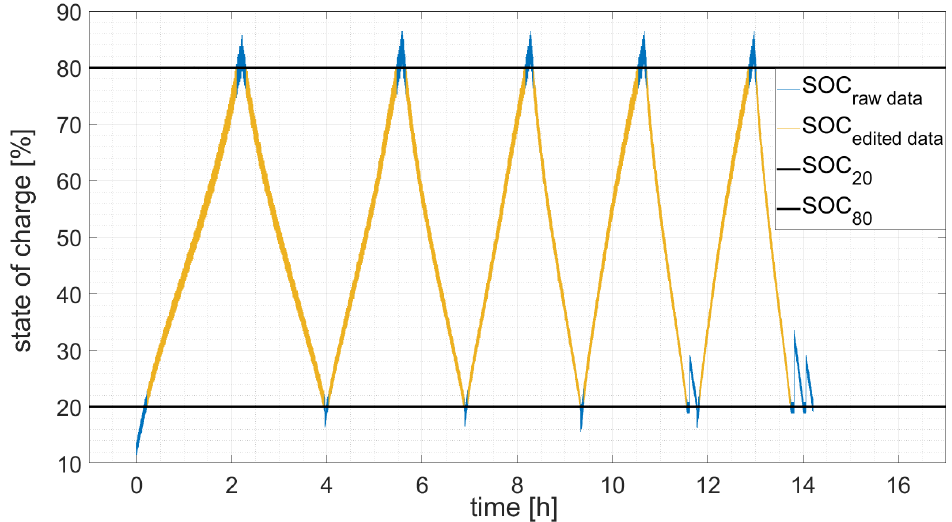
Figure 4. Visualization of the original and edited data from the simulation